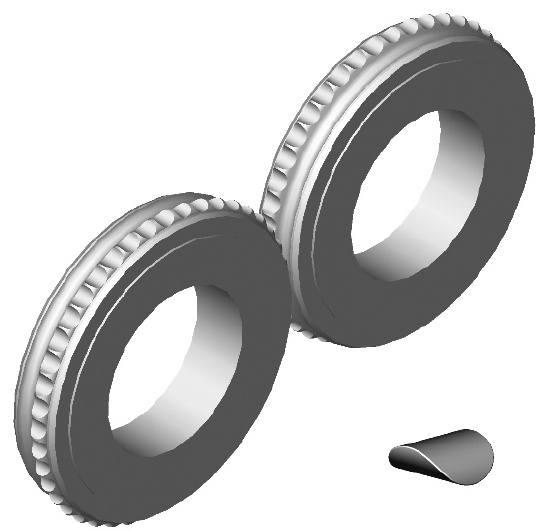
Figure 3. Molding rings used in roller press compaction unit with a saddle-shaped briquette [69].